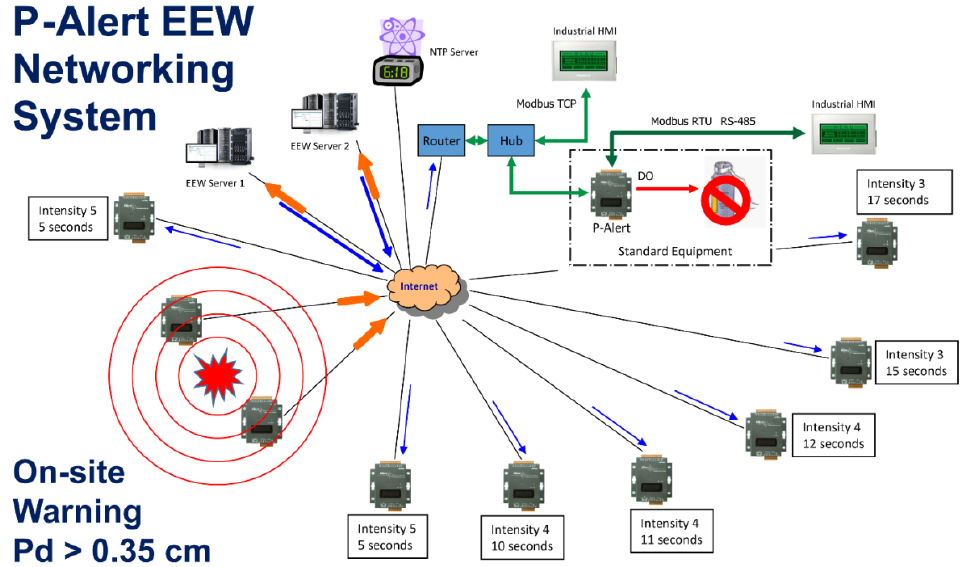
Figure 3. The relationship of 𝑃 (cid:3031) with PGV by augmenting the 638 P-Alert records obtained during the 5 February 2016 Meinong earthquake and the 6 February 2018 Hualien earthquake with 780 rec- ords from Taiwan, Japan, and California via the strong motion instrument used by Wu and Kanamori (2008) [24].